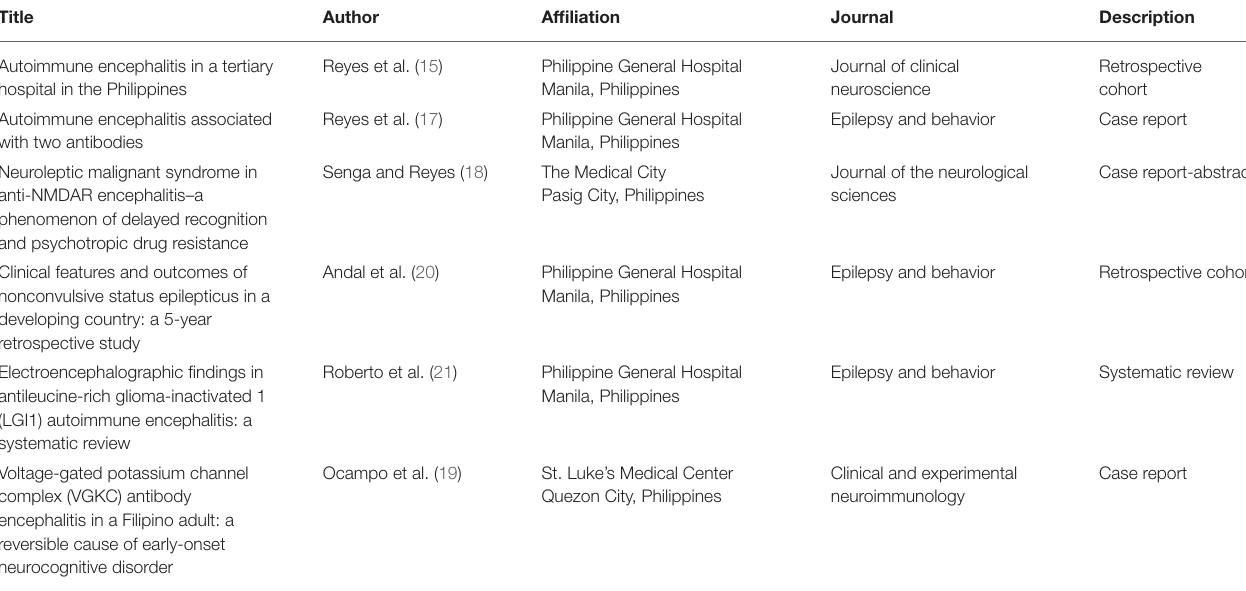
TABLE 2 | Indexed research output on autoimmune encephalitis from the